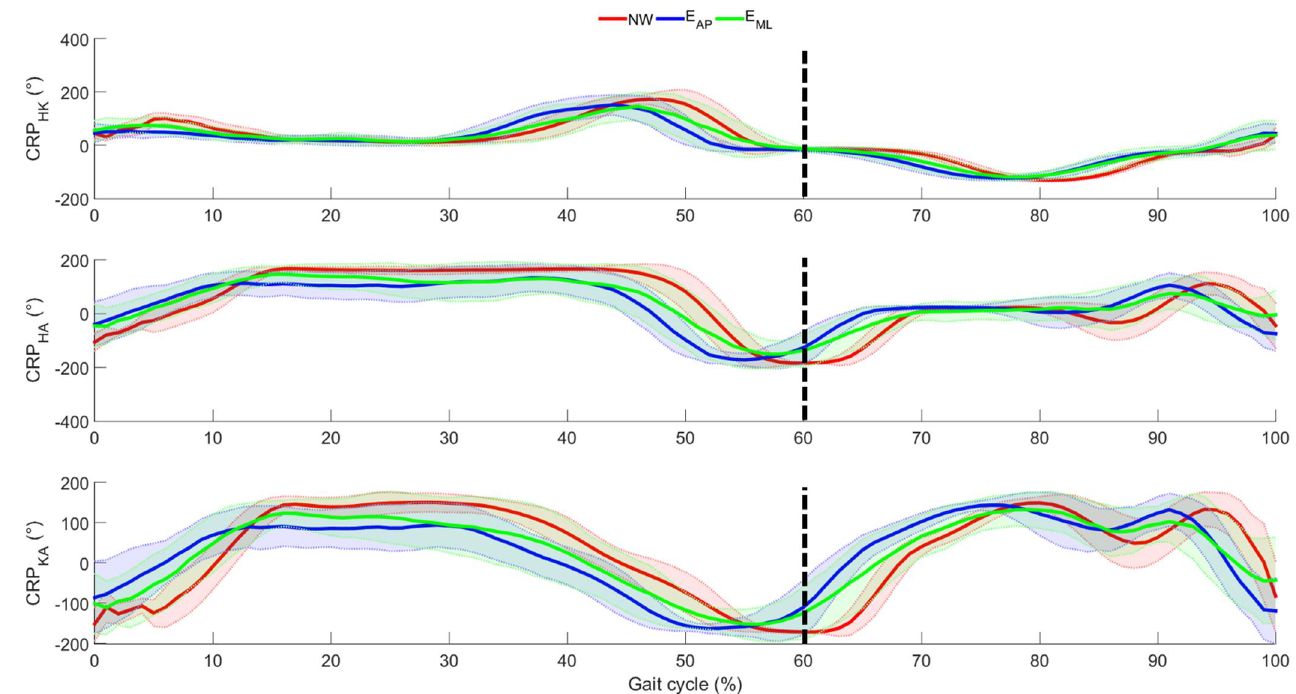
Figure 6. Mean (bold line) and standard deviation (shaded area) of the lower limb joint CRP as averaged across participants. Red, blue, and green are used to identify the normal walking, the perturbed locomotion in anterior-posterior direction, and the perturbed locomotion in medio-lateral direction, respectively. Dotted, black line represents the transition between stance and swing phases in NW.